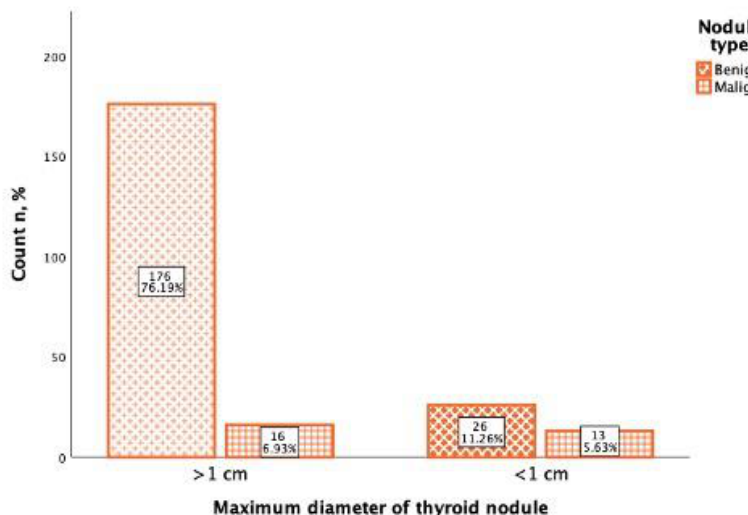
Figure 5. Thyroid nodule malignancy depending on the nodule maximal diameter. Benign nodules are marked with the oblique line pattern and malignant nodules with the check box pattern.